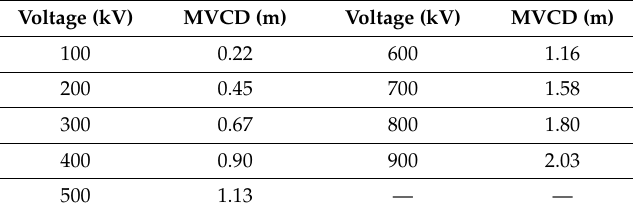
Table 2. MVCD by the Gallet equation for different DC voltages from 100 kV to 900